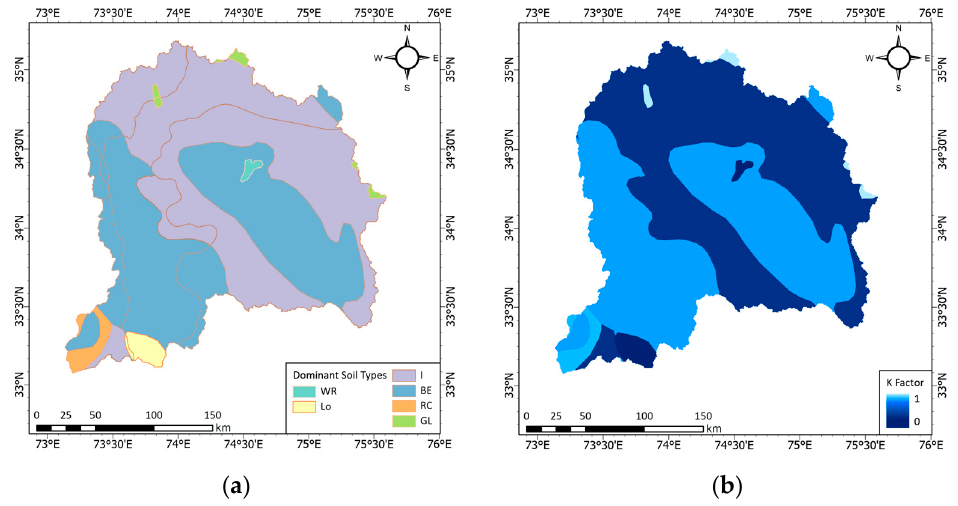
Figure 4. ( a ) Maps of Soil type; ( b ) Soil erodibility (K-factor).